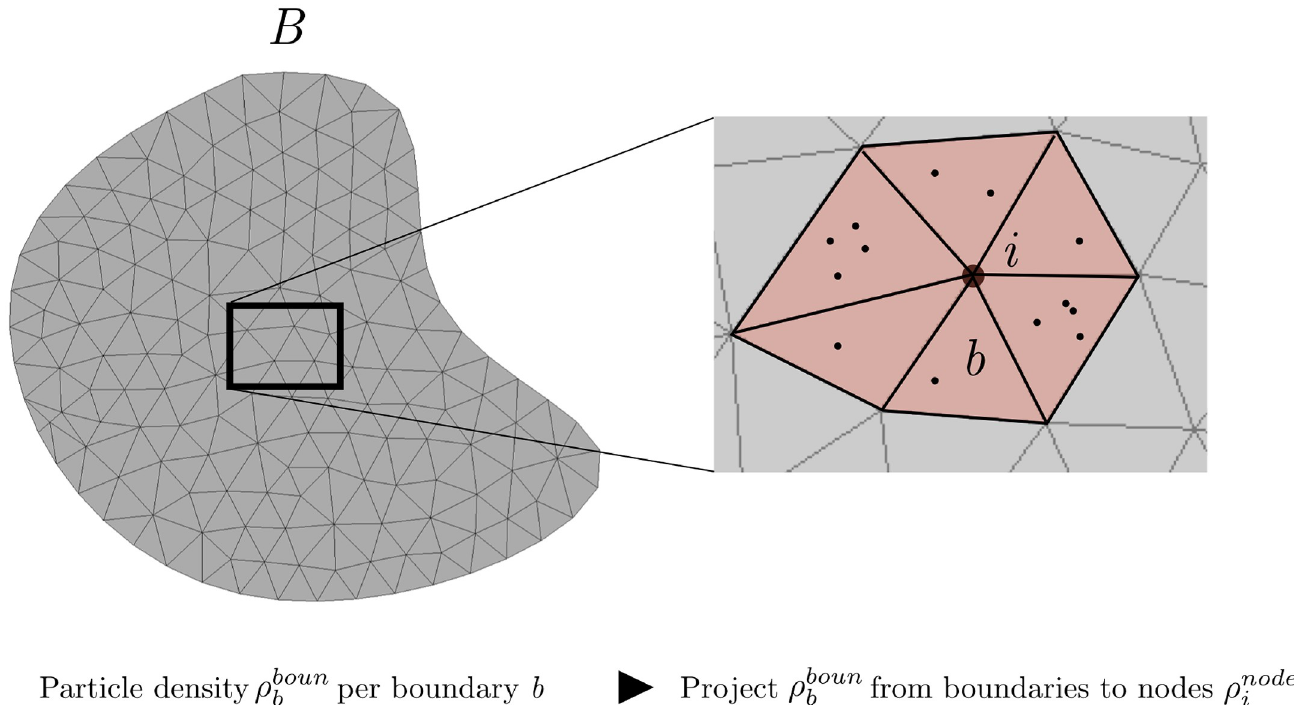
Fig 9. Transferring the boundary density of particles r boun